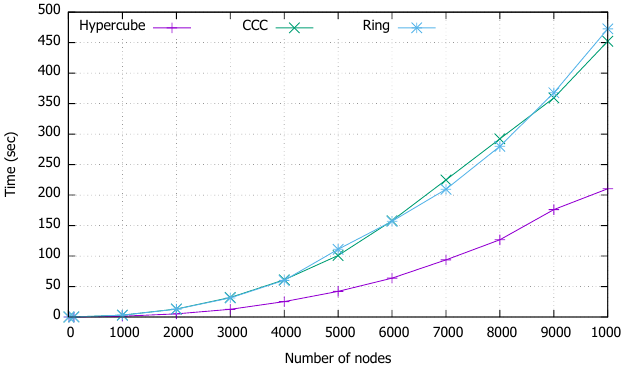
Figure 8. A comparison between the network bootstrapping time for different overlay topology, using SLoPCloud.